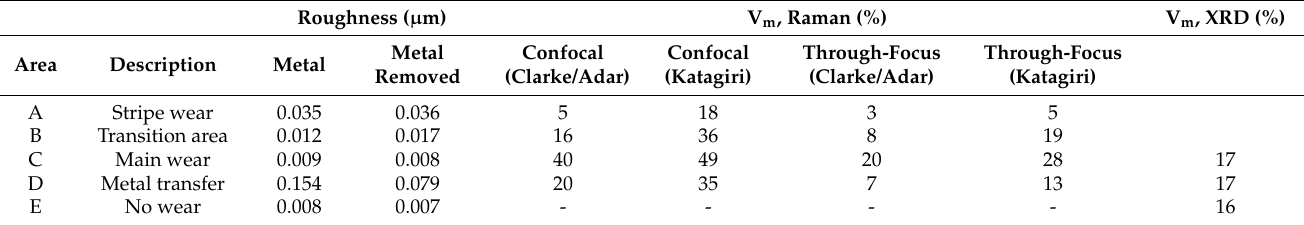
Table 2. Roughness values and values of V m by XRD; Raman V m values are determined as difference from E (non-wear case).